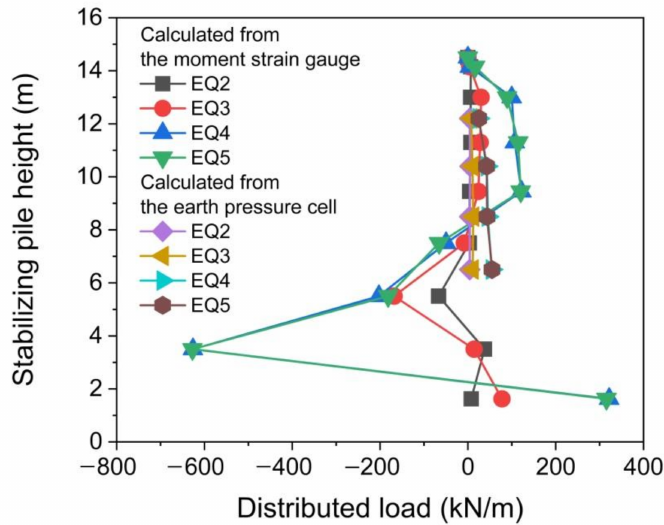
Figure 18. Comparison of distributed load increment obtained by moment strain gauge and earth pressure cell on a stabilizing pile after each shaking event.